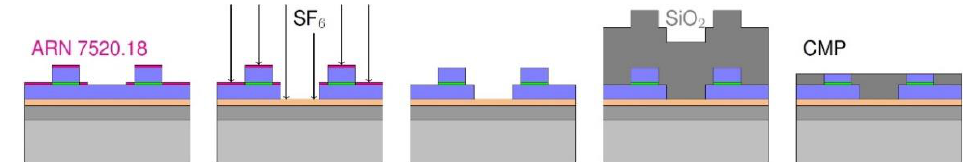
Figure 2. Layer scheme of the nanoSQUID fabrication process to pattern the Nb base layer and of the subsequent chemical – mechanical polishing (CMP) step. The Nb base layer is protected during the ICP RIE etching with SF 6 by a high-resolution negative resist (ARN 7520.18) mask. Afterwards the mask is removed, and the wafer is covered with SiO 2 via plasma enhanced chemical vapor deposition (PECVD). The wafer is planarized through the following CMP step.